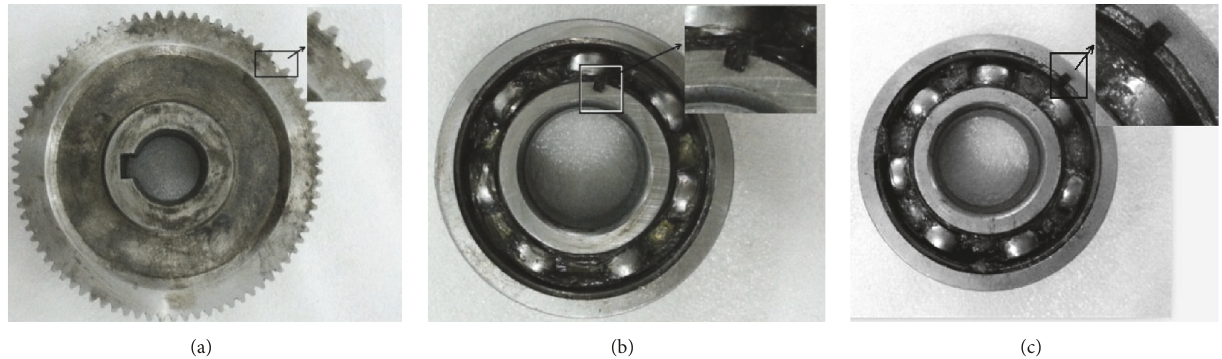
Figure 7: Fault pictures of (a) broken tooth fault, (b) inner circle fault, and (c) outer circle fault.